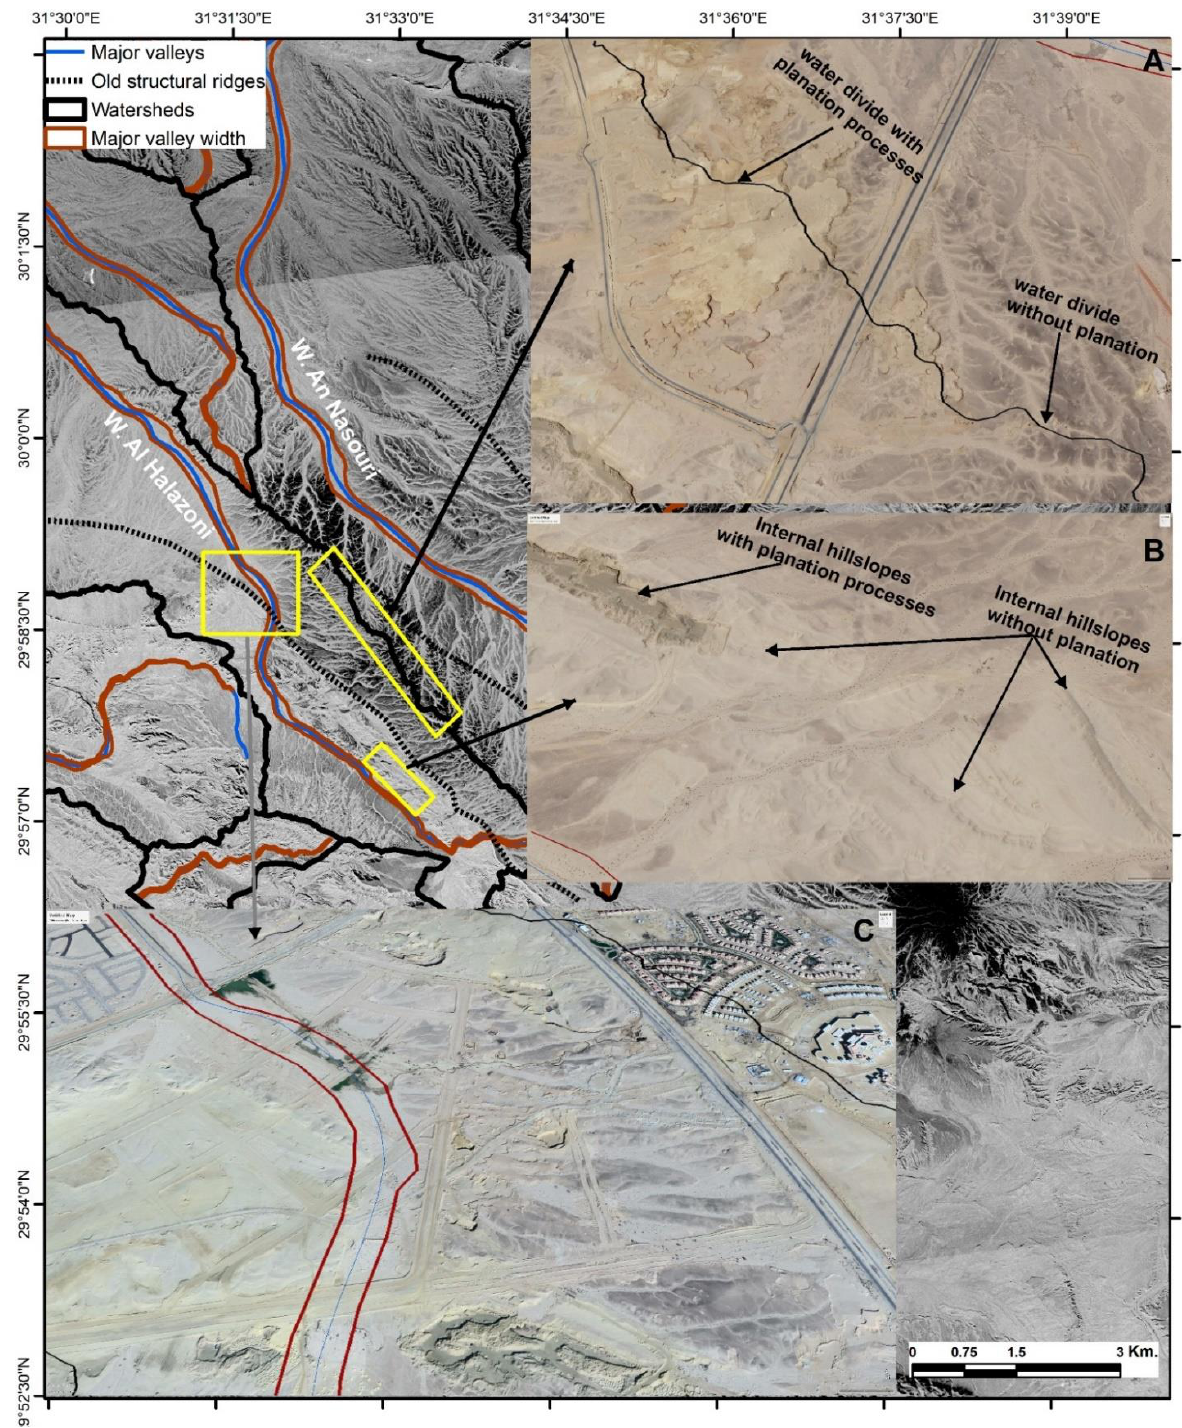
Figure 11. The aggression against water divides ( A ), the internal hillslopes ( B ), and planning across the major trunk valley of W. Al Halazoni ( C ). the major trunk valley of W. Al Halazoni ( C